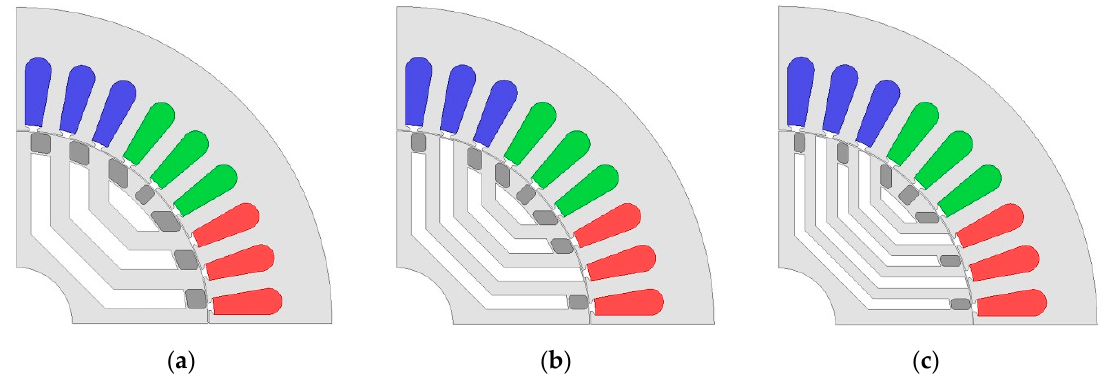
Figure 6. FEA model according to the number of barriers ( a ) model 1, ( b ) model 2, and ( c ) model 3. Table 4. FEA result of LS-SynRM according to the number of barriers.